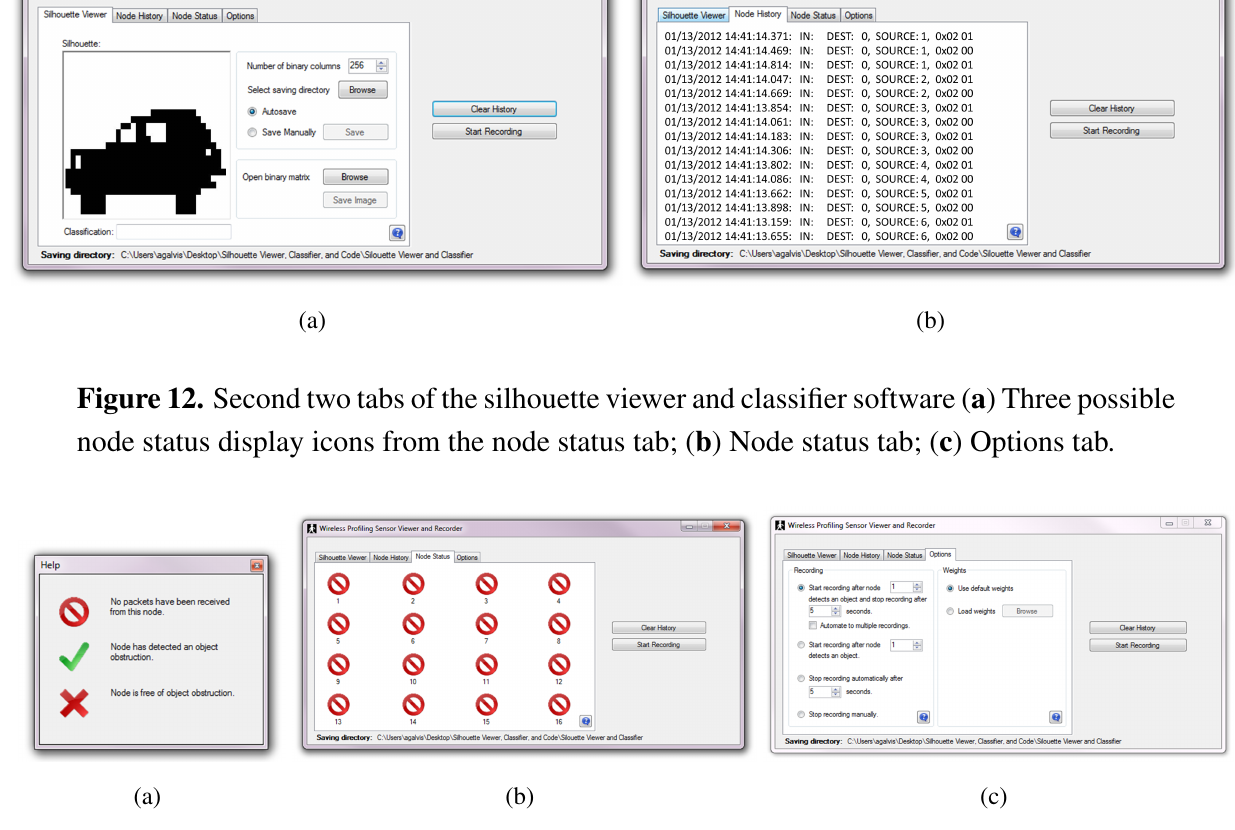
Figure 11. First two tabs of the silhouette viewer and classifier software ( a ) Silhouette viewer tab; ( b ) Node history tab.